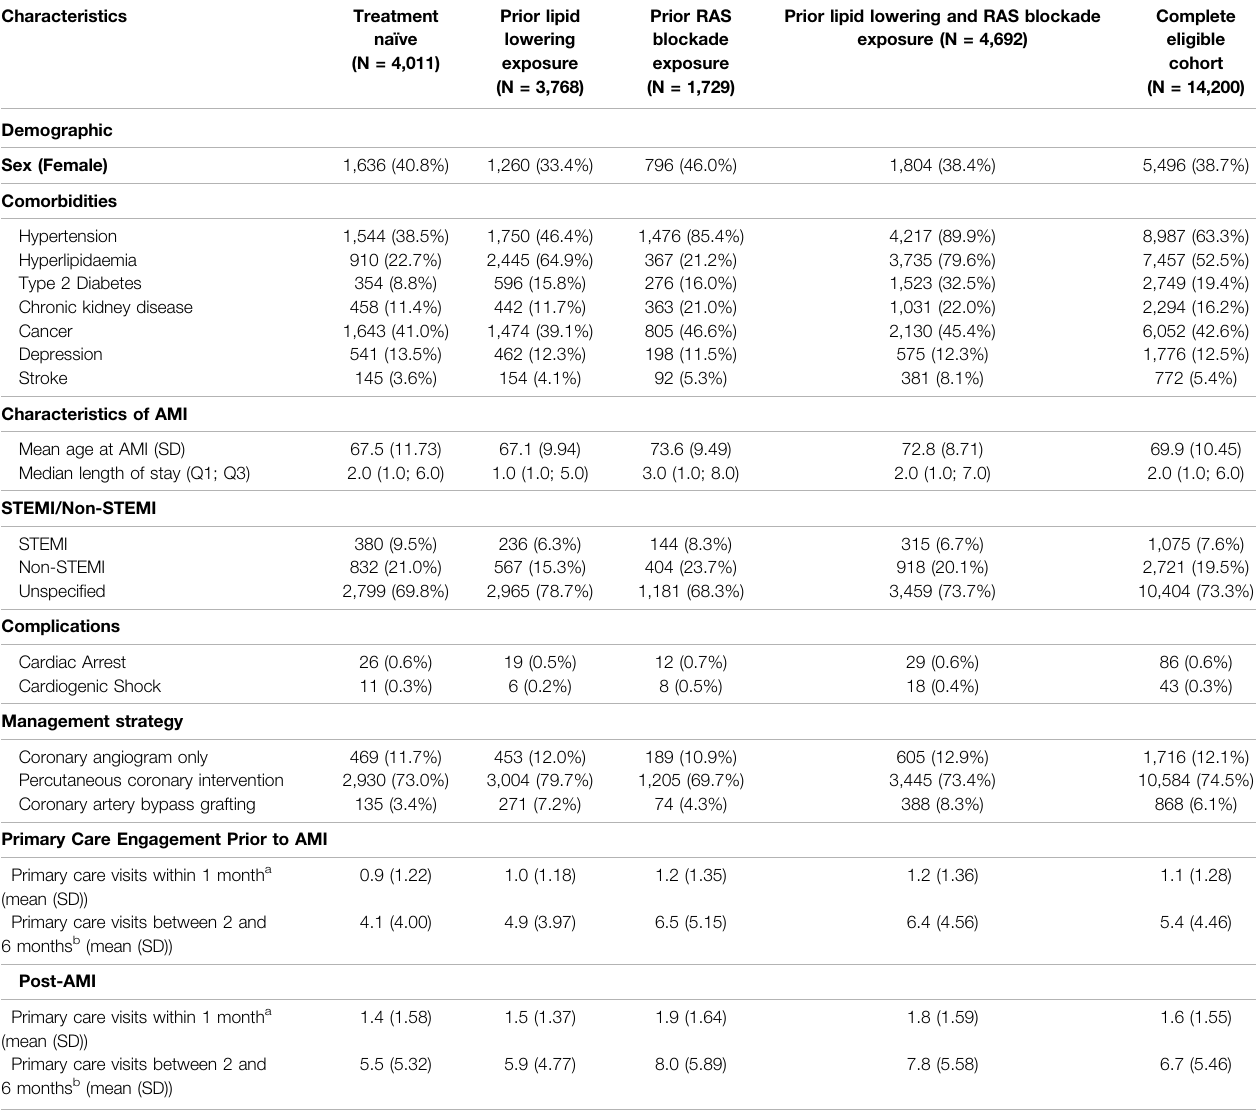
TABLE 1 | Cohort characteristics of people with a fi rst AMI meeting eligibility requirements by prior exposure.